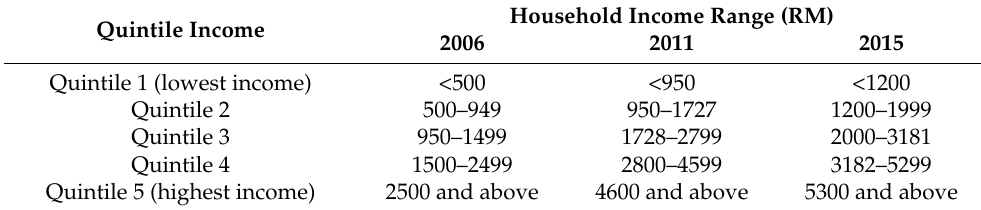
Table A2. Household income range for every